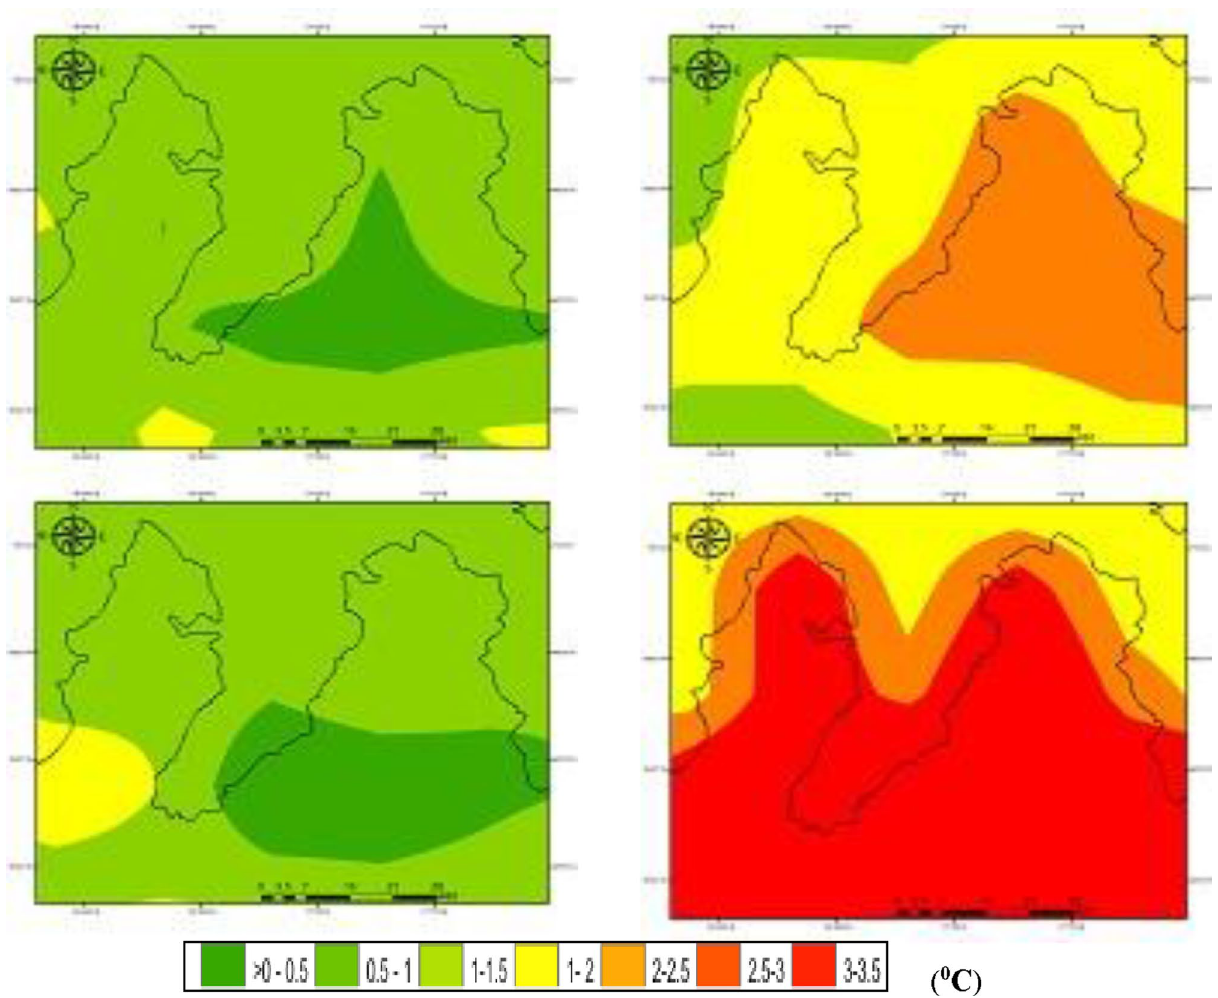
Fig. 3 Spatial changes of seasonal temperature (°C) changes for 2050 (left panel) and 2100 (right panel) to baseline (2010) during the winter (top panel) and summer (bottom panel) under RCP